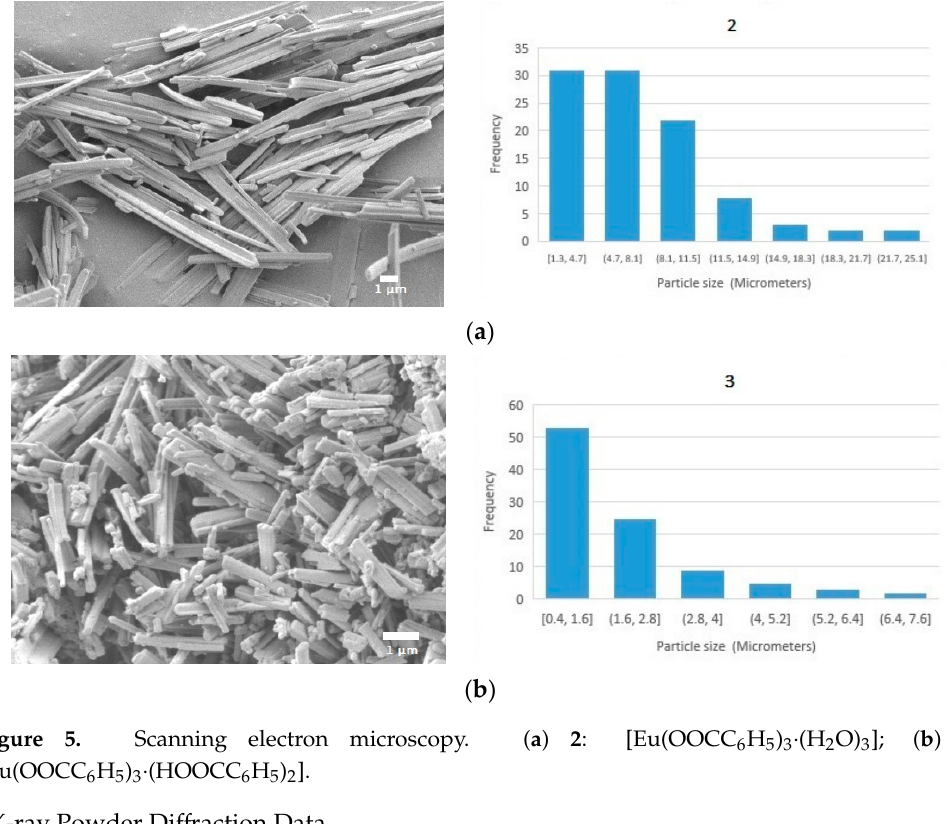
Figure 5. Scanning electron